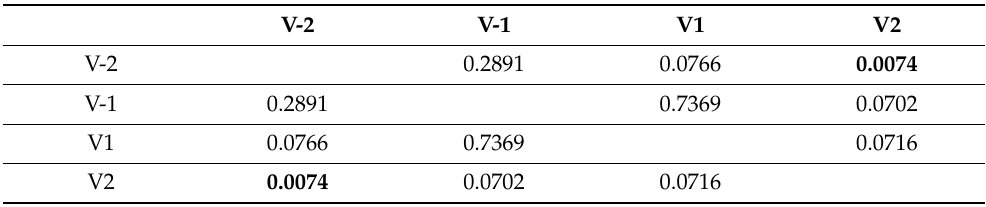
Table 5. Post-hoc analysis of average central retinal thickness during follow-up of ranibizumab (comparisons in